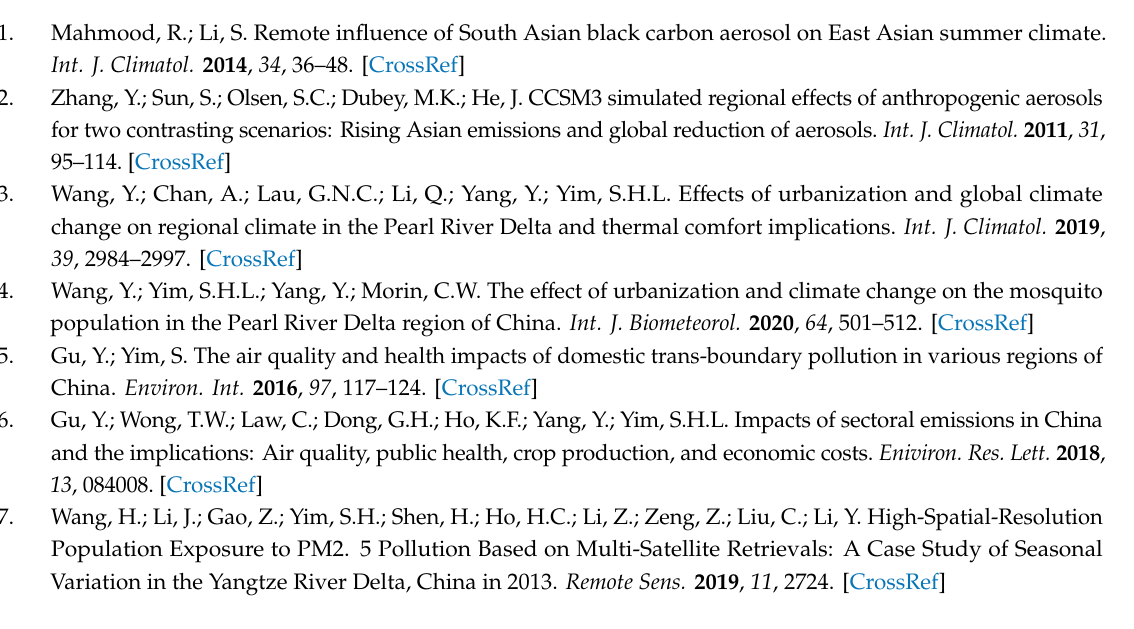
Figure S1: The spatial distribution of 1680 PM 2.5 sites in China until